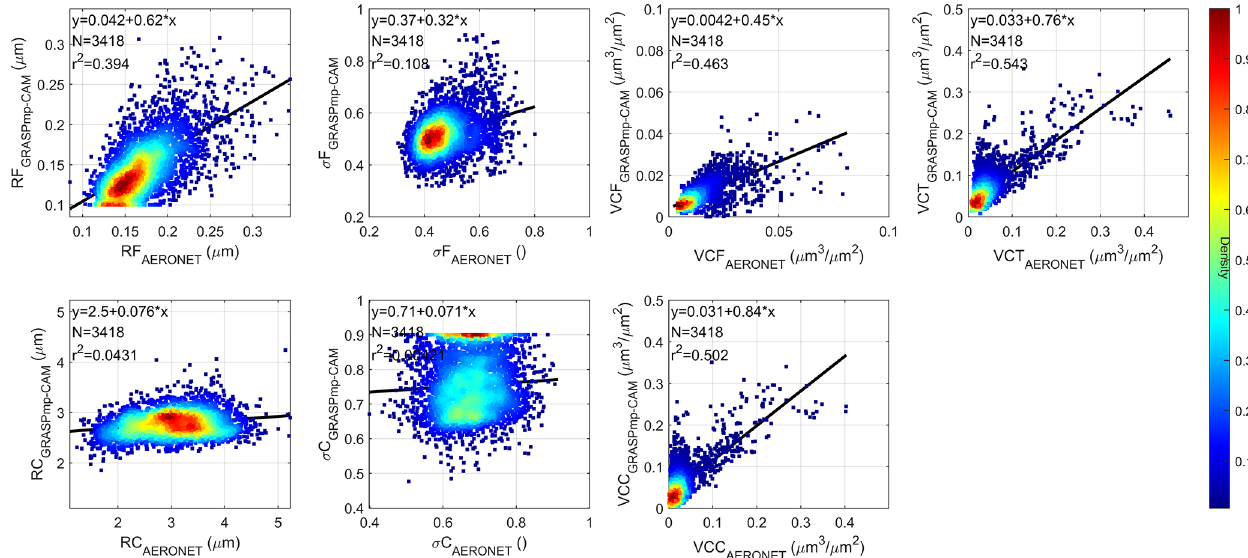
Figure 20. Density scatter plots of the aerosol size distribution properties retrieved by GRASP with the multi-pixel approach (GRASPmp- CAM) versus the ones retrieved by AERONET; linear fit (black line), its equation and the determination coefficient ( r 2 ) are also shown. The size distribution properties are volume median radius of fine (RF) and coarse (RC) modes, standard deviation of log-normal distribution for fine ( σ F) and coarse ( σ C) modes, and aerosol volume concentration for fine (VCF) and coarse (VCC) modes and the total value (VCT).